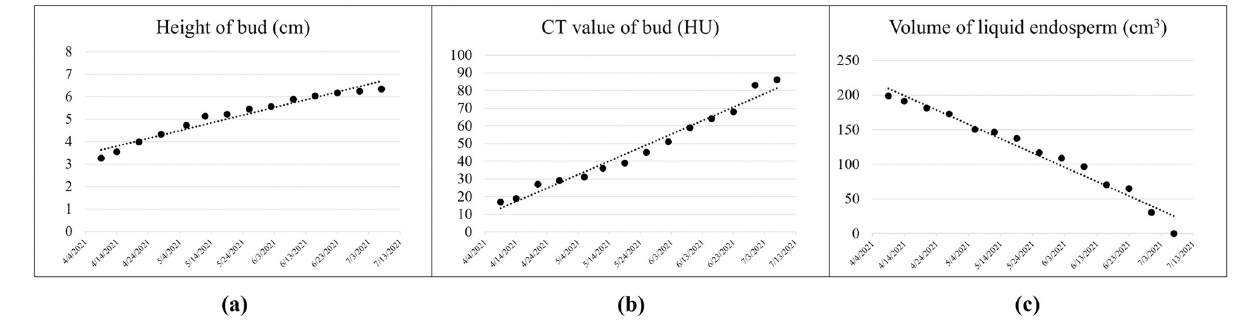
Fig 9. Measurements of a sprouted coconut observed over 3 months.